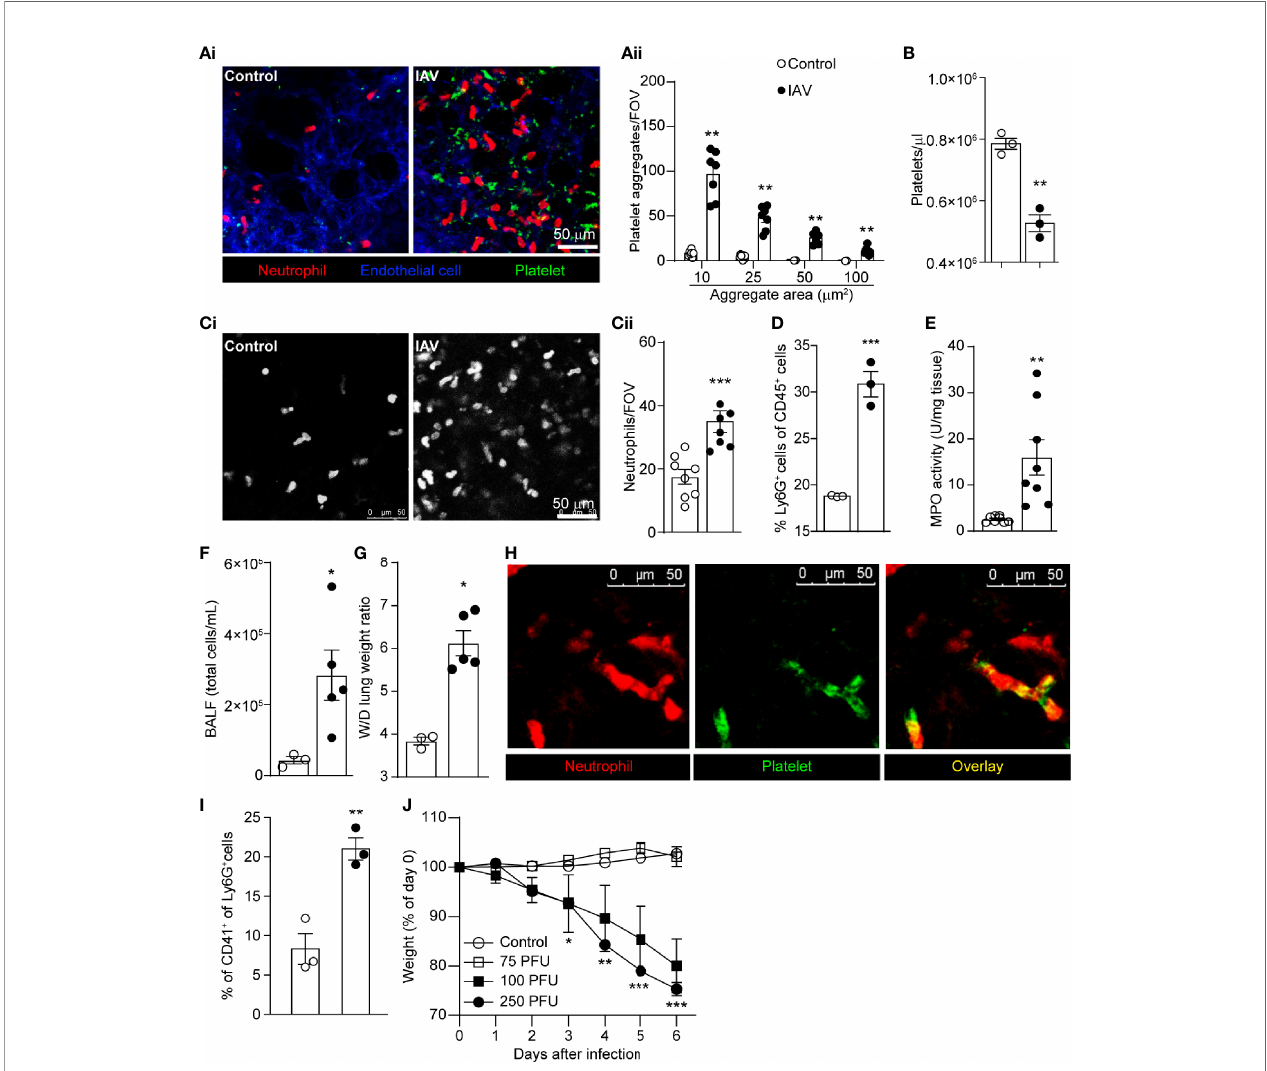
FIGURE 1 | Intranasal IAV Infection of Mice Results in Platelet Aggregation, Neutrophil Recruitment, and Lung Edema. (Ai) Intravital visualization of platelet and neutrophils following administration of PBS or infection with IAV in the lung vasculature (neutrophils, red; platelets, green; endothelium, blue). (Aii) Quanti fi cation of platelet aggregates of the indicated sizes in PBS-treated mice or IAV-challenged mice. Values are shown as mean ± SEM, n=8 per group. (B) Peripheral blood platelet counts in control and IAV-infected mice. (Ci) Imaging (neutrophils, white) and (Cii) quanti fi cation of neutrophil recruitment within the lung in PBS-treated mice or IAV-challenged mice. Values are shown as mean ± SEM, n=6-8 per group. (D) Flow cytometric quanti fi cation of the percentage of neutrophils (Ly6G + cells) in the lung. MPO activity (E) , BALF cell counts (F) and lung wet-to-dry tissue weight ratios (G) following IAV infection. Values are shown as mean ± SEM, n=3-8 per group. (H) Co-localization of neutrophil and platelet aggregates within the lung vasculature of a IAV infected animal (neutrophils, red; platelets, green). (I) Flow cytometric quanti fi cation of the percentage of neutrophils (Ly6G + cells) that are interacting with platelets (CD41 + ) in the lung (J) Animal weight measurements following infection with indicated inoculums of IAV. *p < 0.05, **p < 0.01, ***p < 0.001 compared to the control